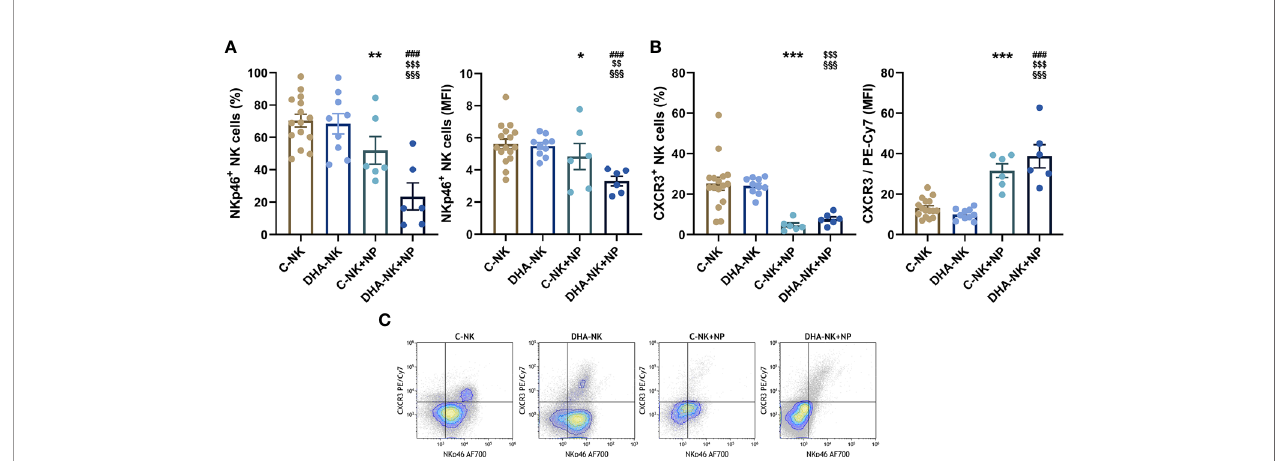
FIGURE 5 | Effects of neutrophils on expression of NKp46 (A, C) and CXCR3 (B, C) on NK cells pre-incubated with DHA or not. NK cells were pre-incubated for 18 h in the absence (C-NK) or presence (DHA-NK) of 50 µM docosahexaenoic acid and then stimulated with IL-2 (2 ng/ml), IL-12 (2 ng/ml), and IL-15 (10 ng/ml) and cultured further for 6 h alone or with neutrophils (C-NK+NP and DHA-NK+NP). Expression levels were determined by fl ow cytometry and are presented either as percent positive cells of the total NK cell population or as mean fl uorescent intensity (MFI) of the positive cell population (A, B) . Positive gating was determined with appropriate isotype controls. Data are shown as mean ± SEM; * indicates difference between C-NK+NP and C-NK, § difference between DHA-NK and DHA-NK +NP, $ difference between DHA-NK+NP and C-NK, and # difference between DHA-NK+NP and C-NK+NP. One symbol indicates p < 0.05, two symbols p < 0.01, and three symbols p < 0.001. n = 6 – 15 (independent donors), collected in at least three independent